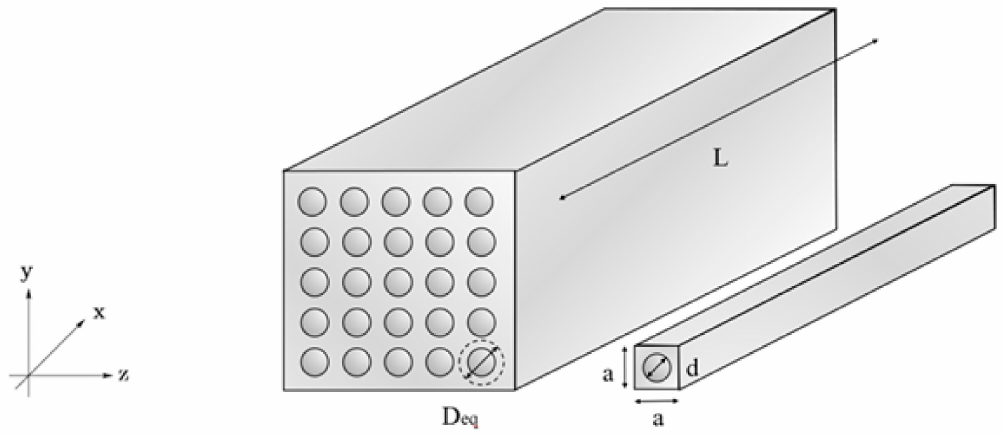
Figure 1. Schematic of the thermal energy storage